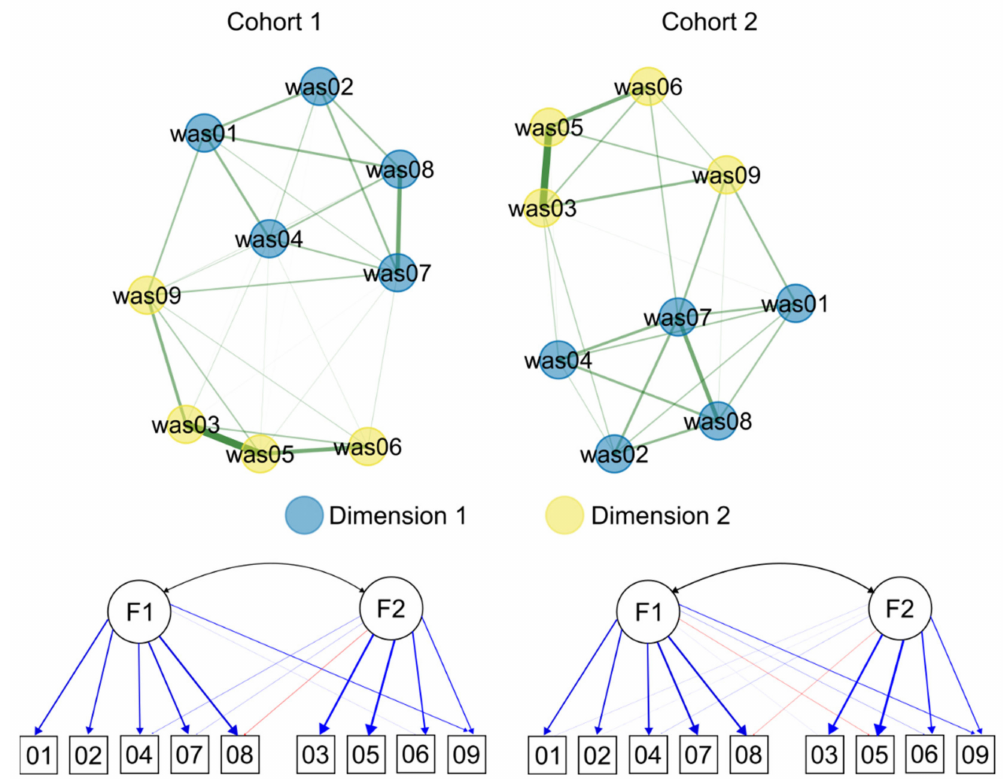
Figure 3. Dimensions that were identified by Exploratory Graph Analysis (EGA, top ) and Exploratory Structural Equation Modeling (ESEM, bottom ). In the EGA plot, the color of the nodes represents the dimension and the thickness of the lines represents the magnitude of the partial correlations. In the ESEM plot, the thickness of the lines represents the magnitude of the pattern coefficients (blue = positive, red = negative) as in Table